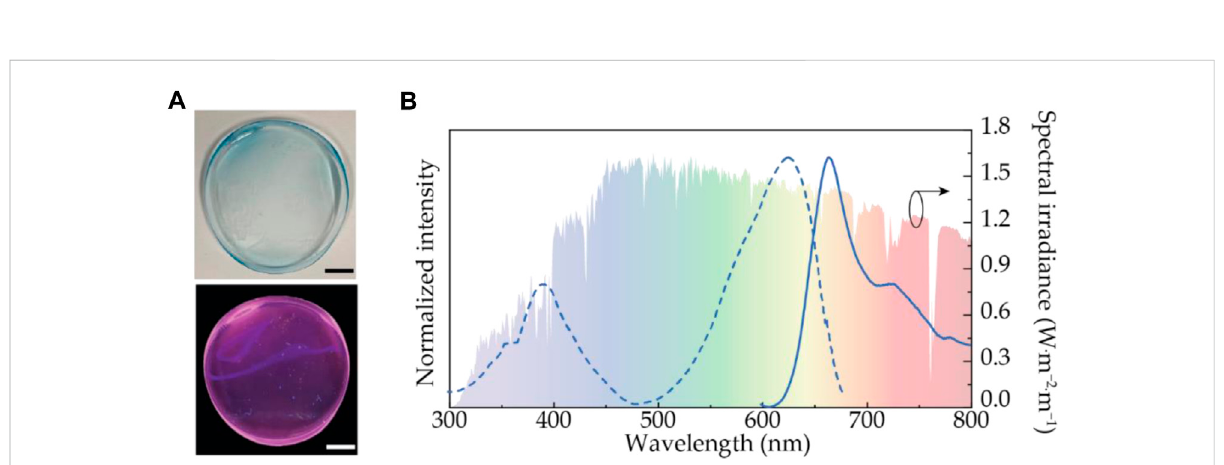
FIGURE 3 (A) Photographs of PC incorporated in PVA (Dias et al., 2022) under white light (top) and UV irradiation at 365 nm (bottom). Scale bars: 10 – 2 m. (B) Emission and excitation spectra excited at 575 nm and monitored at 720, respectively. The c-Si spectral response is shown on the right y-axis. (B) Excitation spectra for R-PE/PVA, C-PC/PVA, and FX/PVA monitored at 720 nm. The shadowed area represents the AM1.5G solar spectrum (right y-axis). Reproduced from (Dias et al., 2022) under a CC BY 4.0